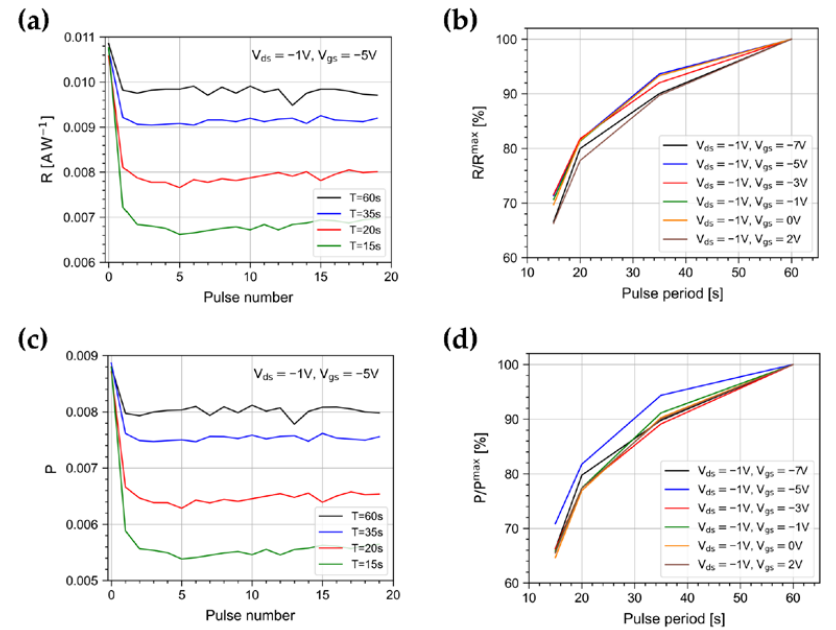
Figure 8. Trends of ( a ) R and ( c ) P for pulses in the burst, for different periods, at V ds = − 1 V and V gs = − 5 V. Averages of ( b ) R and ( d ) P in the burst, normalized to the values at 60 s, as a function of the light pulse period for different gate polarizations.